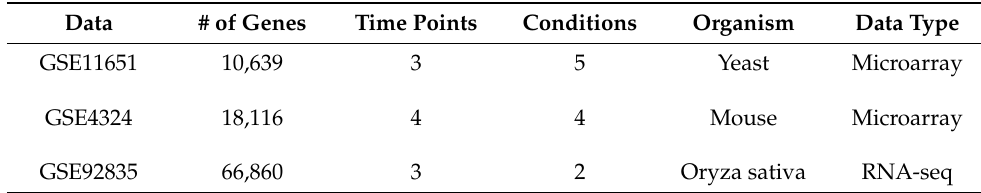
Table 2. Dataset statistics of the three case studies.